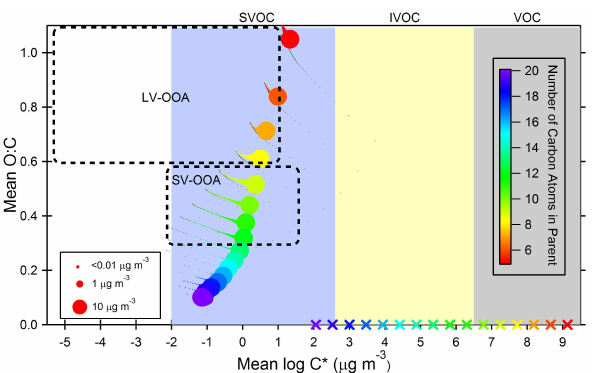
Fig. 13. The evolution of SOA formed from SOA precursor com- pounds with 5 ≤ N C ≤ 20 over 1 lifetime of oxidation where 10µgm − 3 SOA has been formed. Points are colored by the num- ber of atoms comprising the SOA precursor and the symbol size corresponds to the amount of OA formed. The precursor species properties are indicated as x ’s. Regions designating LV-OOA and SV-OOA are from Jimenez et al.